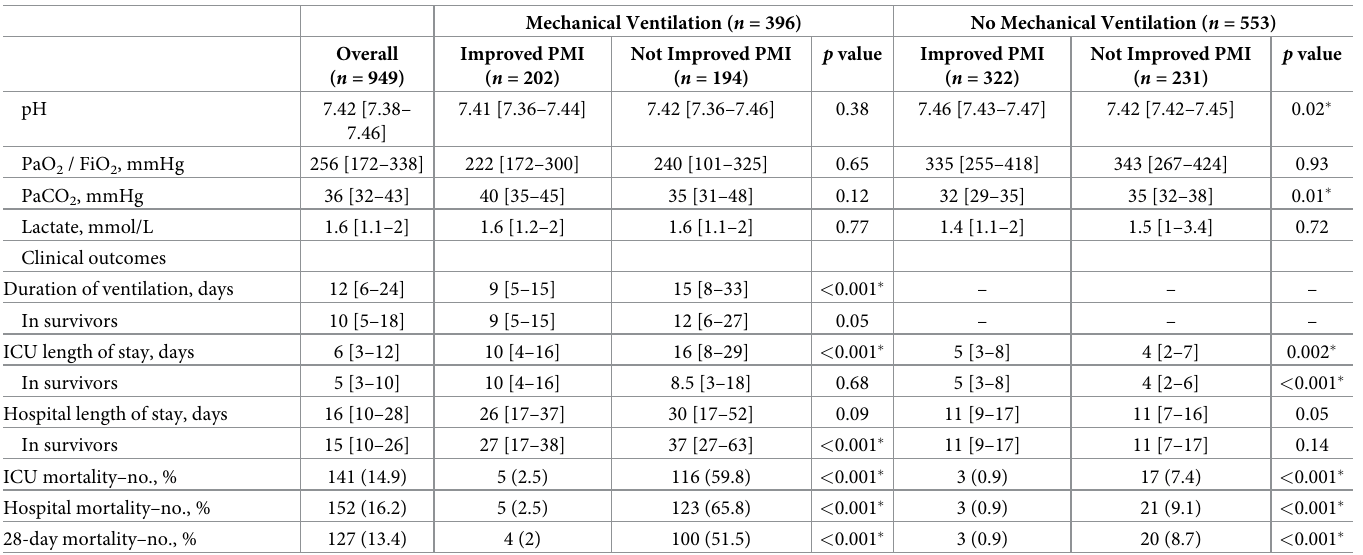
Key elements of mobilization The percentage of patients able to get out of bed during ICU stay was lower in patients receiv- ing MV (36.4% vs. 72.0% in patients not receiving ventilation; p < 0.001), in older patients (51.2% vs. 64.1% in young patients; p < 0.001), in more severe patients (45.2% vs. 69.4% in less severe patients; p < 0.001), in more comorbid patients (50.1% vs. 64.1% in less comorbidity; p < 0.001), and in frail patients (41.2% vs. 56.5% in pre-frail vs. 65.7% in non-frail; p < 0.001), data are presented in Table 3 and S5 Table . In addition, the percentage of patients walking > 30 meters during ICU stay followed the same